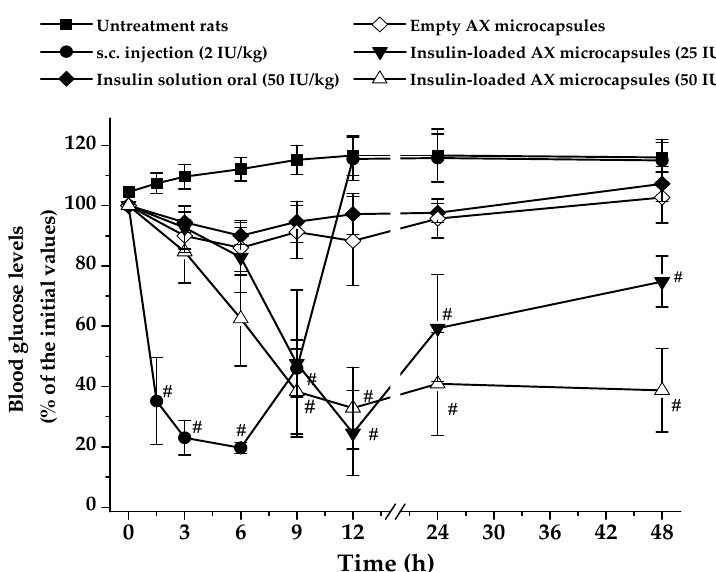
Figure 6. Hypoglycemic effect of various insulin formulations after oral or subcutaneous admin- istrations to diabetic rats. Data represent the mean ± SD, n ≥ 5 per group. # p <0.05 compared to untreated rats, empty AX microcapsules, or oral insulin solution.